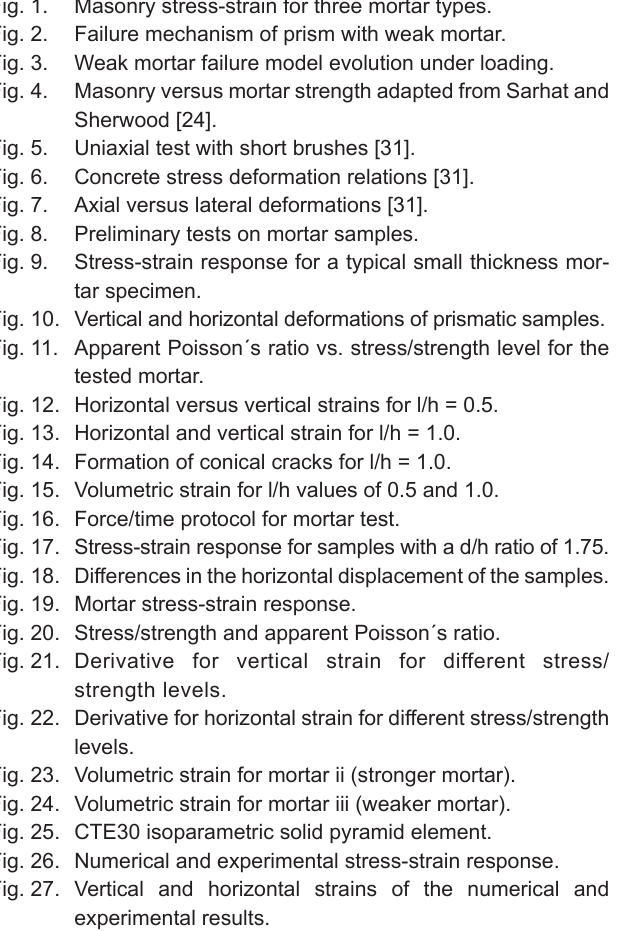
Fig. 1. Masonry stress-strain for three mortar types. Fig. 2. Failure mechanism of prism with weak mortar. Fig. 3. Weak mortar failure model evolution under loading. Fig. 4. Masonry versus mortar strength adapted from Sarhat and Sherwood [24]. Fig. 5. Uniaxial test with short brushes [31]. Fig. 6. Concrete stress deformation relations [31]. Fig. 7. Axial versus lateral deformations [31]. Fig. 8. Preliminary tests on mortar samples. Fig. 9. Stress-strain response for a typical small thickness mor- tar specimen. Fig. 10. Vertical and horizontal deformations of prismatic samples. Fig. 11. Apparent Poisson´s ratio vs. stress/strength level for the tested mortar. Fig. 12. Horizontal versus vertical strains for l/h = 0.5. Fig. 13. Horizontal and vertical strain for l/h = 1.0. Fig. 14. Formation of conical cracks for l/h = 1.0. Fig. 15. Volumetric strain for l/h values of 0.5 and 1.0. Fig. 16. Force/time protocol for mortar test. Fig. 17. Stress-strain response for samples with a d/h ratio of 1.75. Fig. 18. Differences in the horizontal displacement of the samples. Fig. 19. Mortar stress-strain response. Fig. 20. Stress/strength and apparent Poisson´s ratio. Fig. 21. Derivative for vertical strain for different stress/ strength levels. Fig. 22. Derivative for horizontal strain for different stress/strength levels. Fig. 23. Volumetric strain for mortar ii (stronger mortar). Fig. 24. Volumetric strain for mortar iii (weaker mortar). Fig. 25. CTE30 isoparametric solid pyramid element. Fig. 26. Numerical and experimental stress-strain response. Fig. 27. Vertical and horizontal strains of the numerical and experimental